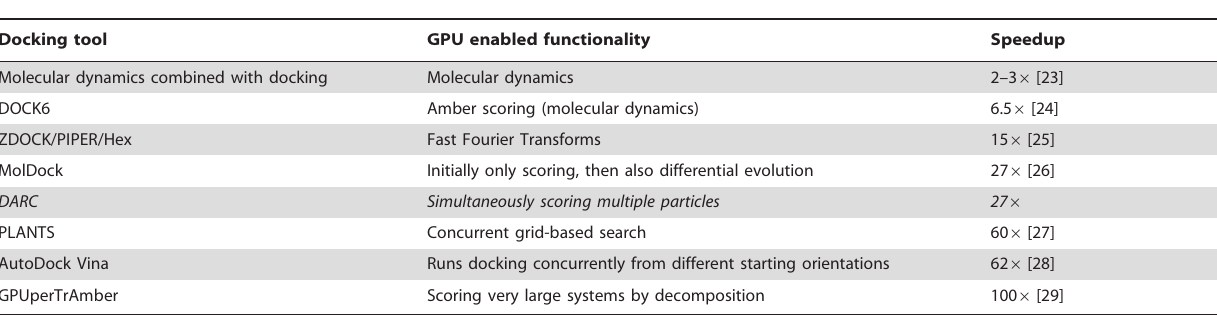
Table 1. Comparison of GPU-enabled docking